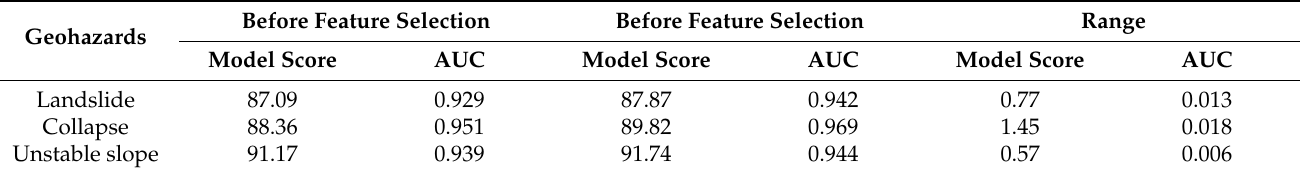
Table 6. Changes in model score and AUC after using filter-MDI feature selection method.